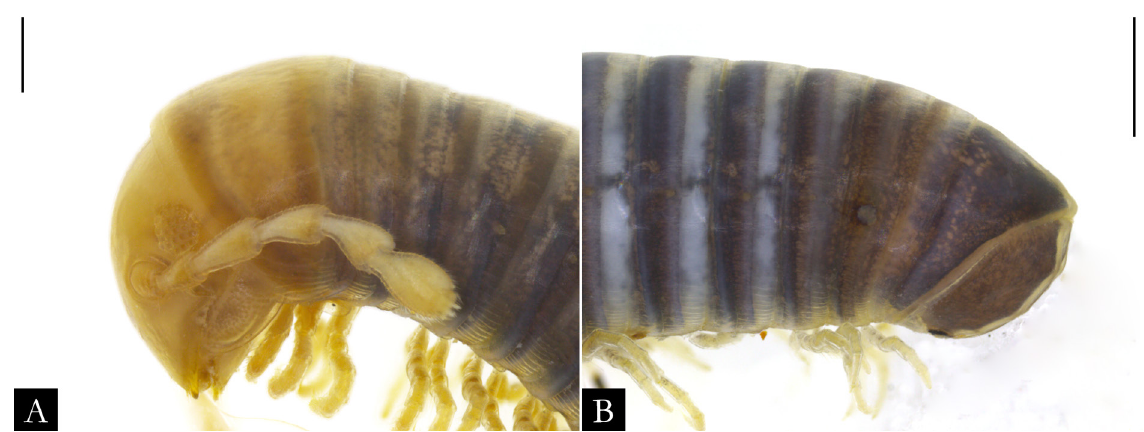
Fig. 44. Pseudonannolene alegrensis Silvestri, 1897 (MCN 626), in lateral view. A . Anterior region. B . Posterior region. Scale bars: A = 0.5 mm; B = 1